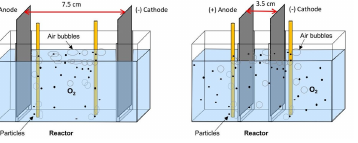
Figure 11. Schematic representations of the 3D electrochemical cell for the two tested interelectrode distances and effect on the particulate electrode distribution (biochar 1–2 mm, 1 mg/mL